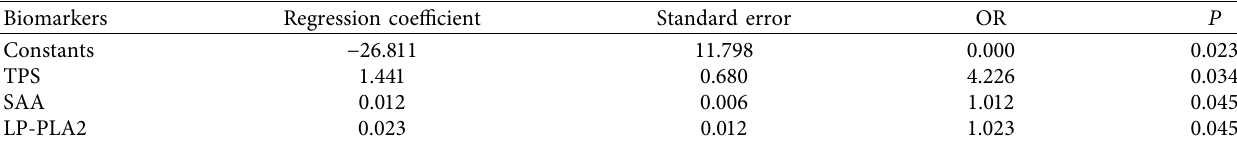
Table 4: Logistic regression analysis of large artery atherosclerotic cerebral